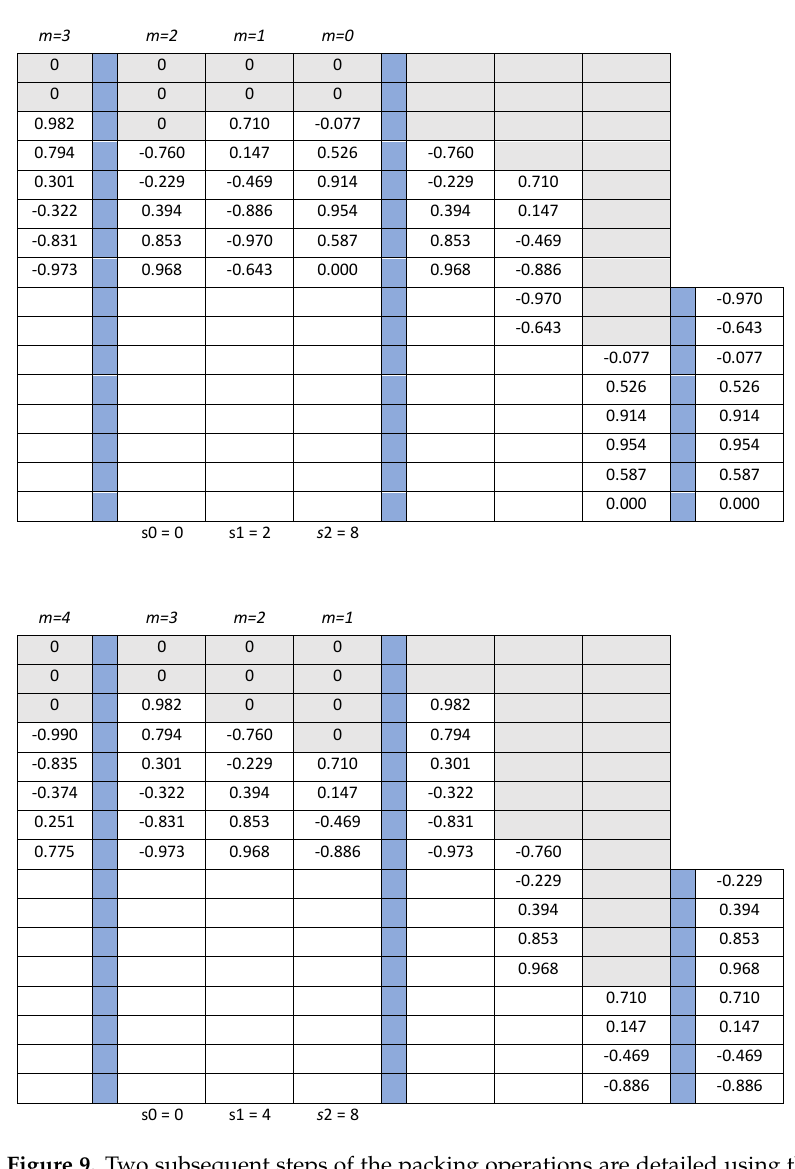
Figure 9. Two subsequent steps of the packing operations are detailed using the re-sampled data given in Figure 8; the 8-size arrays on the right side are the ones stored in the acquisition memory. The proposed solution represents an add-on for the circuitry that interfaces the time- interleaved channels to the acquisition memory. A physical synthesis in a 14 nm